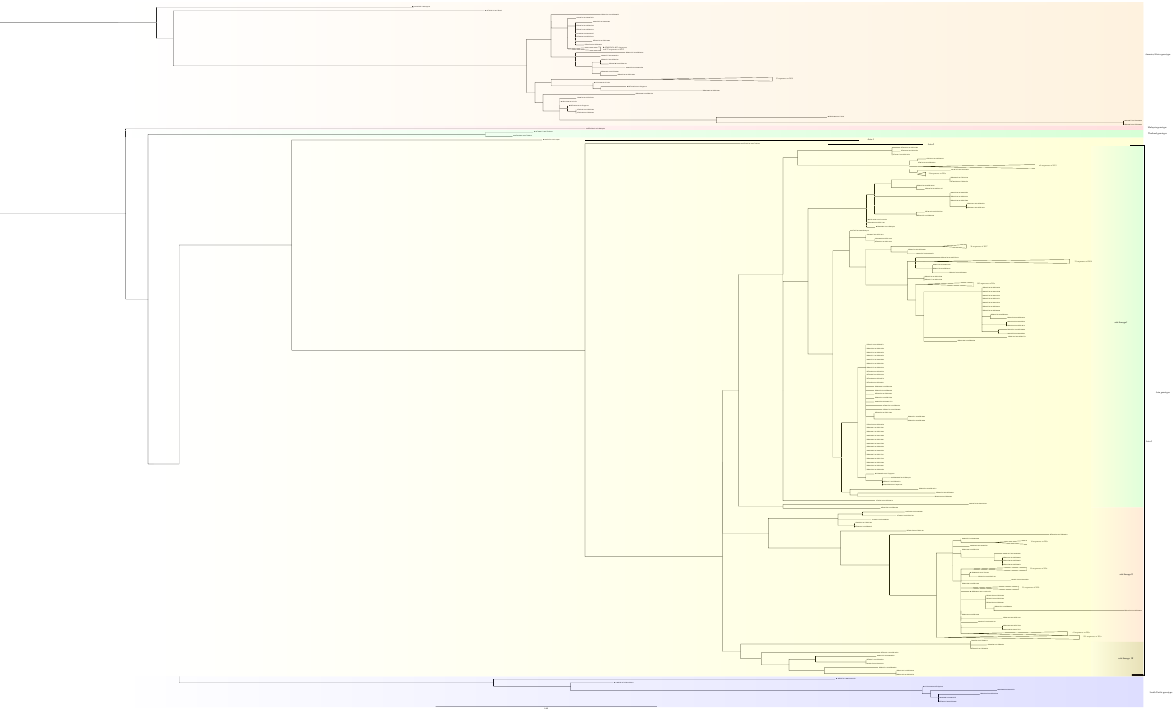
Figure 2. Phylogenetic trees of DENV1 E gene sequences. The reference sequences are indicated with black triangles for clarity, with the accession number, and year and country of isolation. Sequences detected in Guangzhou between 2010 and 2019 are indicated with the accession number, year of isolation, and the laboratory number. Some branches, including sequences from 1 year, are collapsed for clarity. A more detailed phylogenetic tree is shown in Figure